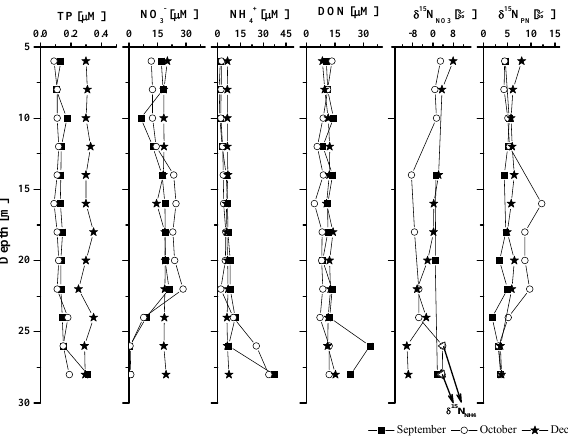
Fig. 3. Depth profiles of total phosphorous (TP), concentrations of nitrate (NO − ), ammonium (NH + ) and dissolved organic ni- 3 4 trogen (DON), together with the isotope composition of nitrate ( δ 15 N NO ) and particulate nitrogen ( δ 15 N PN ) in the water column 3 from September to December 2009 at sampling point D.